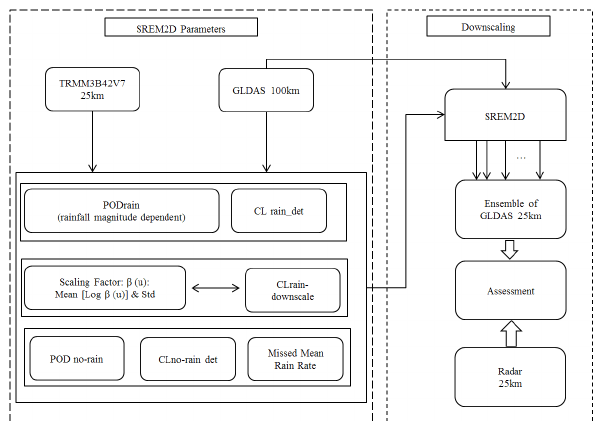
Figure 3. Stochastic downscaling framework. It consists of two main parts: the left side indicates required SREM2D parameters and the right side shows GLDAS ensemble generation and quality assessment with the absolute reference data (stage IV radar